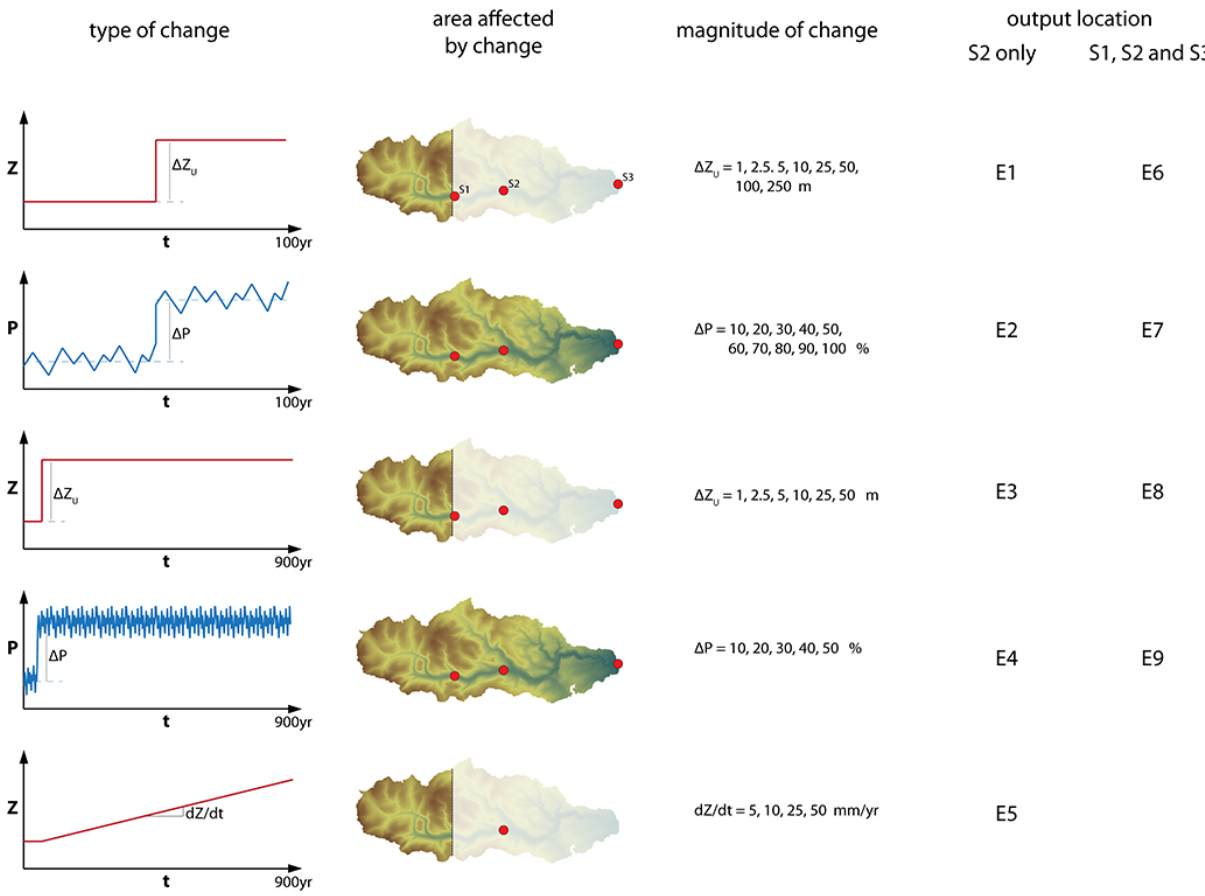
Figure 2. Schematic representation of experiment design. Nine numerical experiments were carried out (E1 to E9). Each experiment consists of a group of 4 to 10 simulations, where either rainfall (blue) or uplift (red) was altered after 50yr into the simulation. In uplift experiments, only the western part of the basin is uplifted. Changes in rainfall a ff ect the entire basin. Red dots on the maps indicate position of output points S1, S2 and